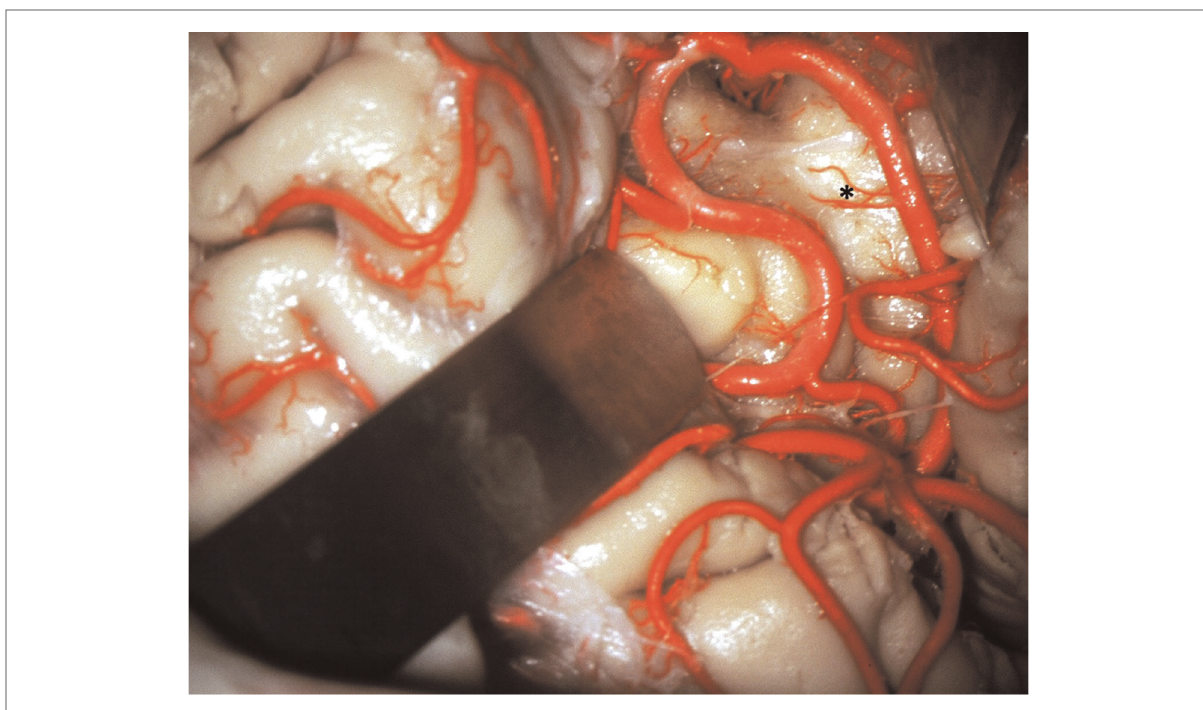
FIGURE 12 The vascularization of the insular cortex is provided by numerous small branches originating from the MCA M2 segment (*). In the resection of insular gliomas these branches can be coagulated.